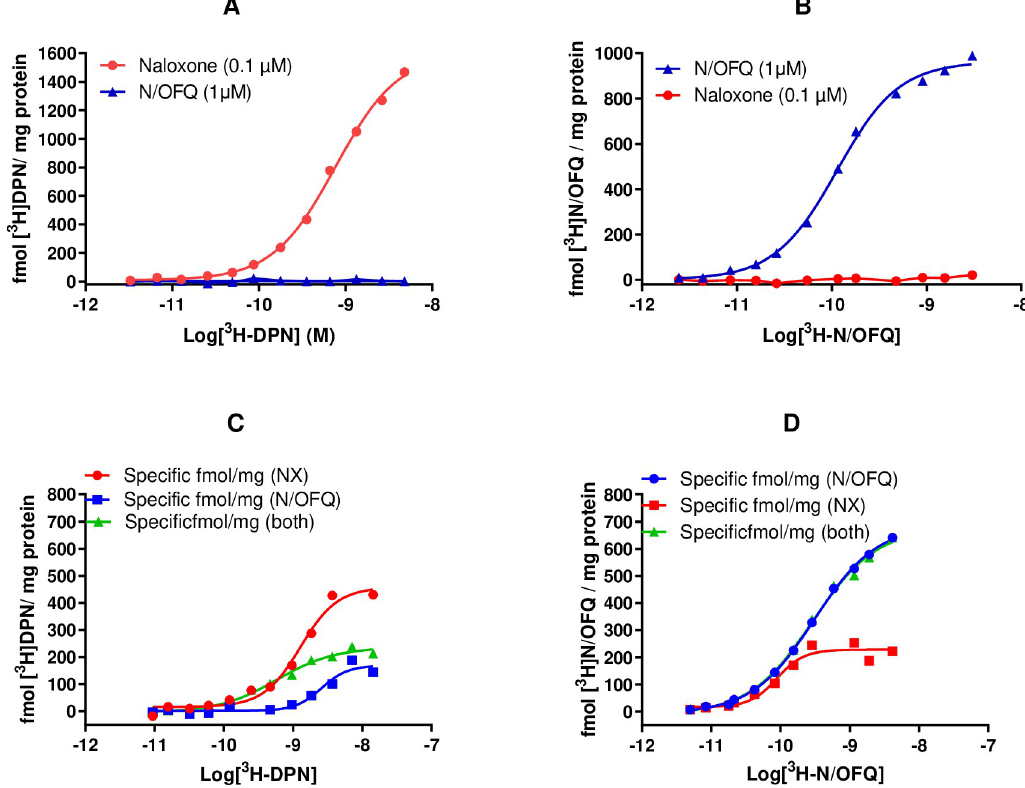
Fig 3. Representative saturation binding curves of A) [ 3 H]-DPN binding in HEK MOP cell membranes B) [ 3 H]-N/OFQ binding in HEK NOP cell membranes. Representative saturation binding curves C) [ 3 H]-DPN binding or D) [ 3 H]-N/OFQ binding in HEK MOP/NOP cell membranes. Data are the mean ( ± SEM) of n = 5 experiments.